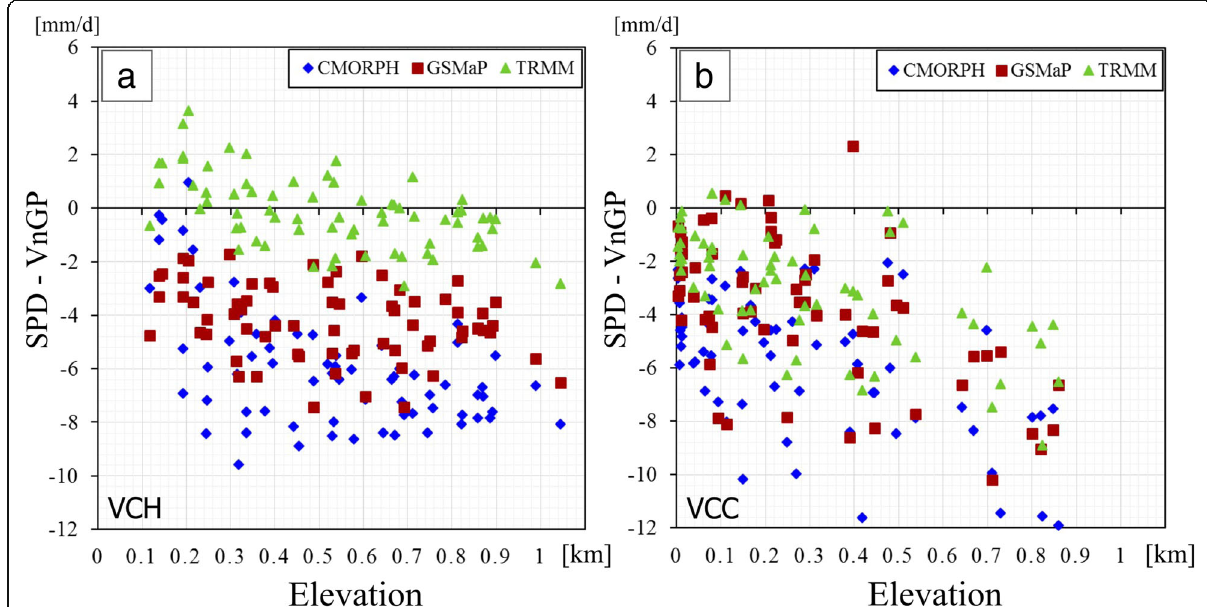
Fig. 13 Scatter plots for grid point averaged elevation (abscissa, unit km) and the time-averaged rainfall bias (SPDs rainfall minus VnGP rainfall; ordinate, unit mm day − 1 ) for a MJJA over the VCH and b SOND over the VCC in 2001 –